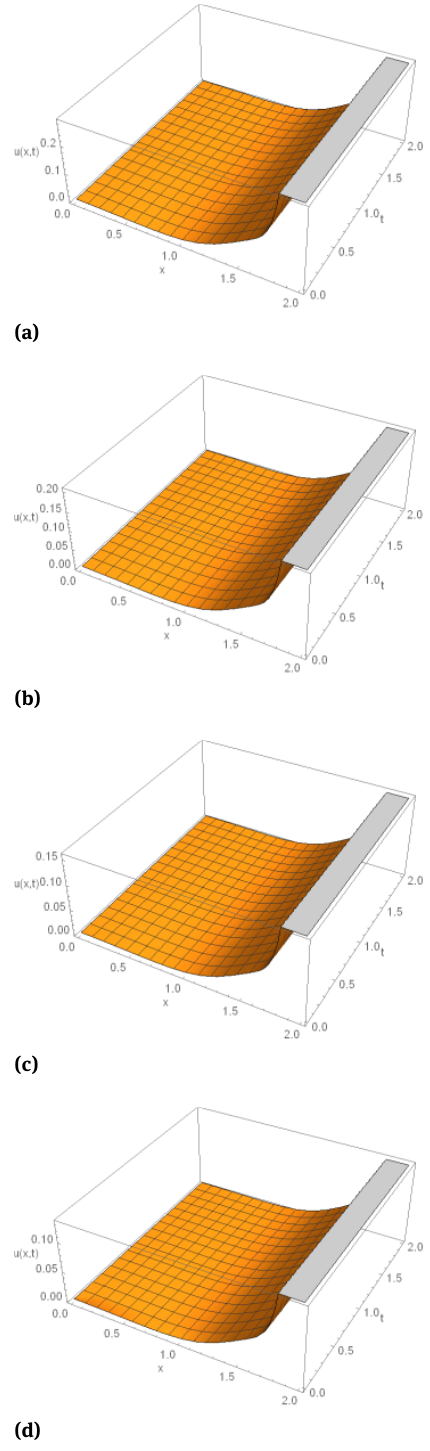
Figure 2: The surface graph of approximate solution ρ ( x , t ) for case- I: (a) ρ ( x , t ) for β = 0.4 (b) ρ ( x , t ) for β = 0.6 (c) ρ ( x , t ) for β = 0.8 (d) ρ ( x , t ) for β = 1